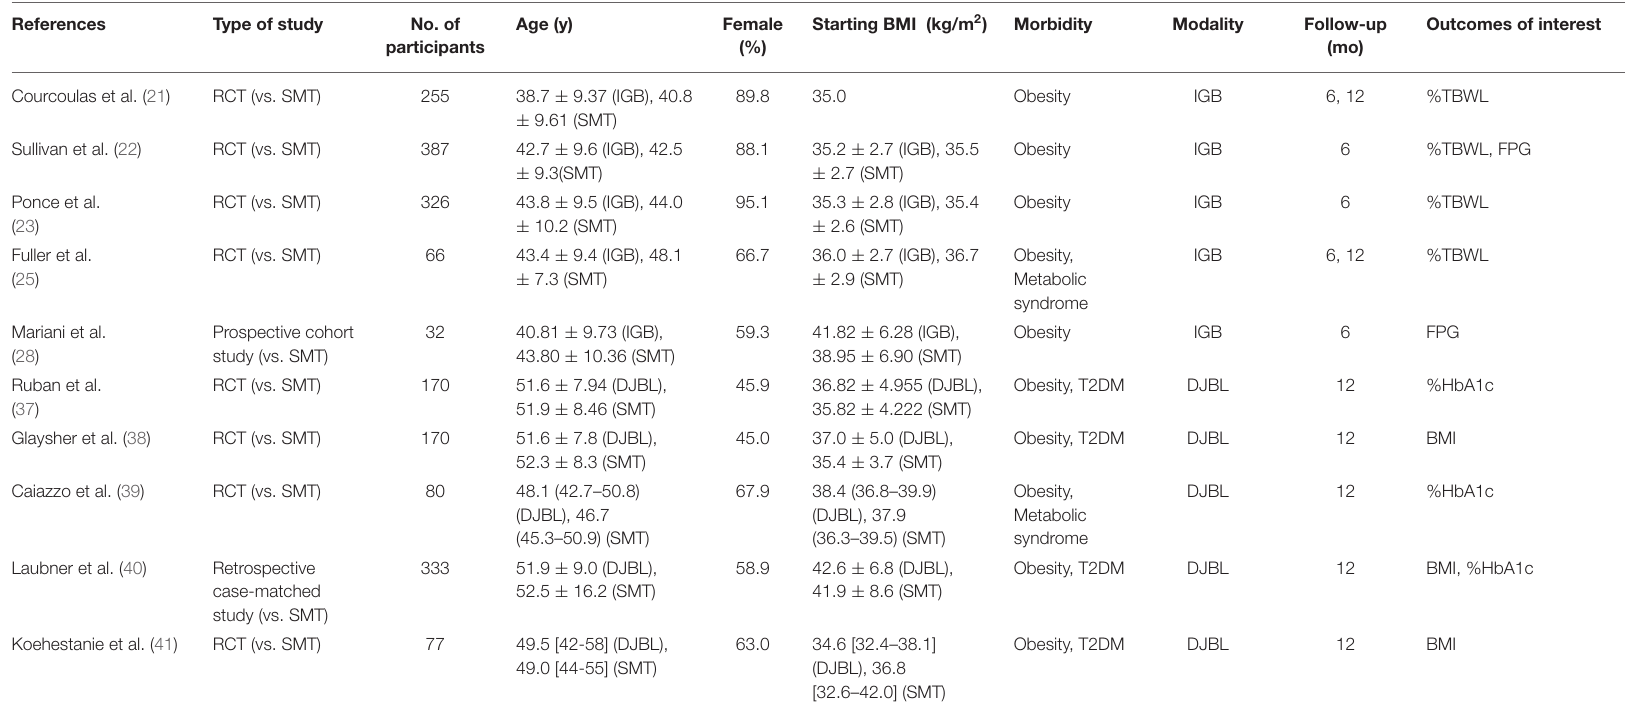
TABLE 2 | Summary of studies included in the